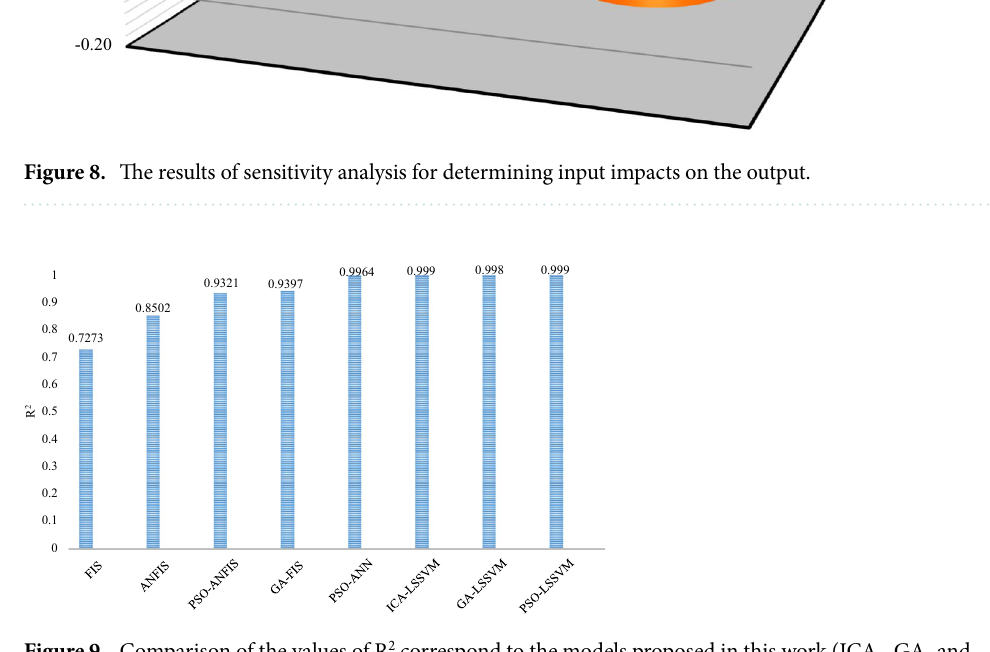
Figure 9. Comparison of the values of R 2 correspond to the models proposed in this work (ICA-, GA- and PSO-LSSVM) with models available in the literature including FIS 71 , ANFIS 15 , PSO-ANFIS 15 , GA-FIS 71 , and PSO-ANN 71